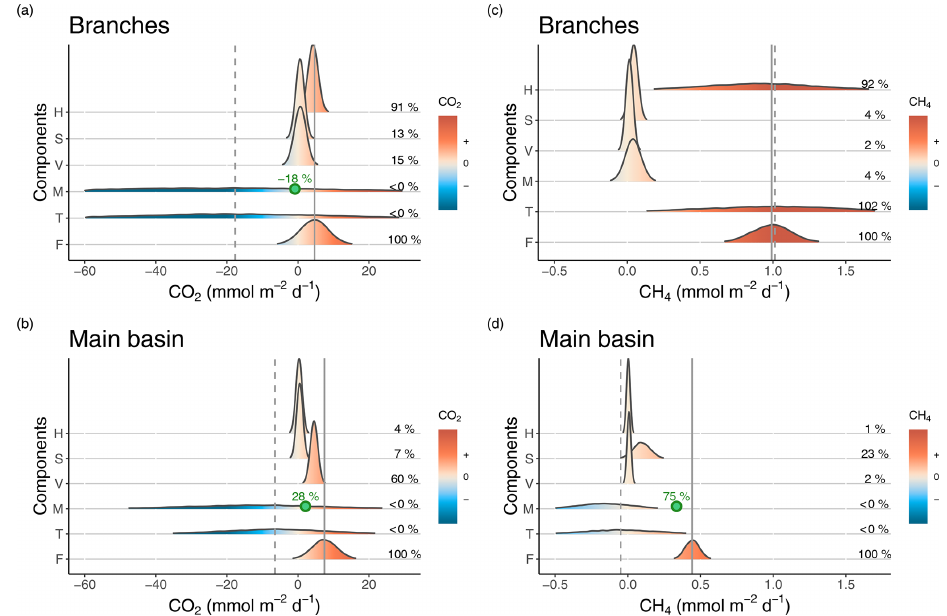
Figure 3. Density distributions of the different components of CO 2 (a, b) and CH 4 (c, d) surface budgets in the reservoir branches (a, c) and main basin (b, d) . Components are as follows. H : horizontal flow inputs; S : sediment inputs; V : vertical inputs; M : net metabolism (average of the incubation and diel O 2 monitoring methods); T : sum of all estimated sources and processes in the surface layer; F : measured surface fluxes. Density curves are based on simulated normal distributions using the mean and standard error of each component. The x axes represent the areal rate of CO 2 or CH 4 , and the colour scale indicates the sign of the rate. Mean values of the fraction of each component (%) relative to the mean surface flux ( F ) are reported on the right side in each panel. The solid and dashed grey lines represent the means of F and T respectively. In panels ( a ), ( b ), and ( d ), the point and percentage in green represent the hypothetical value of the M rate (the most uncertain component) and its corresponding fraction (as a percentage of F ) that are needed to close the budget (to obtain T = F